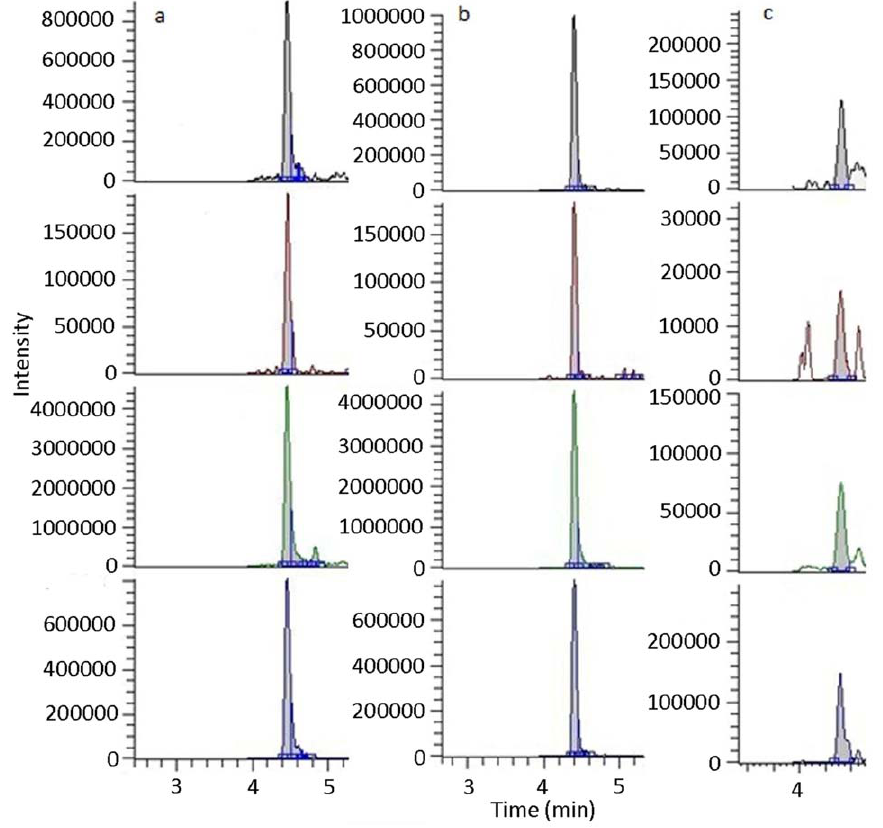
Figure 2. Cyanobacteria produce AEG [N-( 2 -aminoethyl)glycine], both in axenic PCC strains and environmental samples. Using triple quadrupole LC-MS/MS analysis, AEG was identified using a precursor ion m/z 459 and selective reaction monitoring of four transitions m/z 459 to m/z 289 (top pane), m/z 214 (second pane), m/z 171 (third pane), and m/z 119 (bottom pane). a, AEG was detected as a free or weakly bound compound in axenic Nostoc PCC 7120. b, A synthetic AEG standard. c, AEG in an extract of bound compounds from an environmental cyanobacterial sample collected at Benson Marina, Logan, Utah, USA.